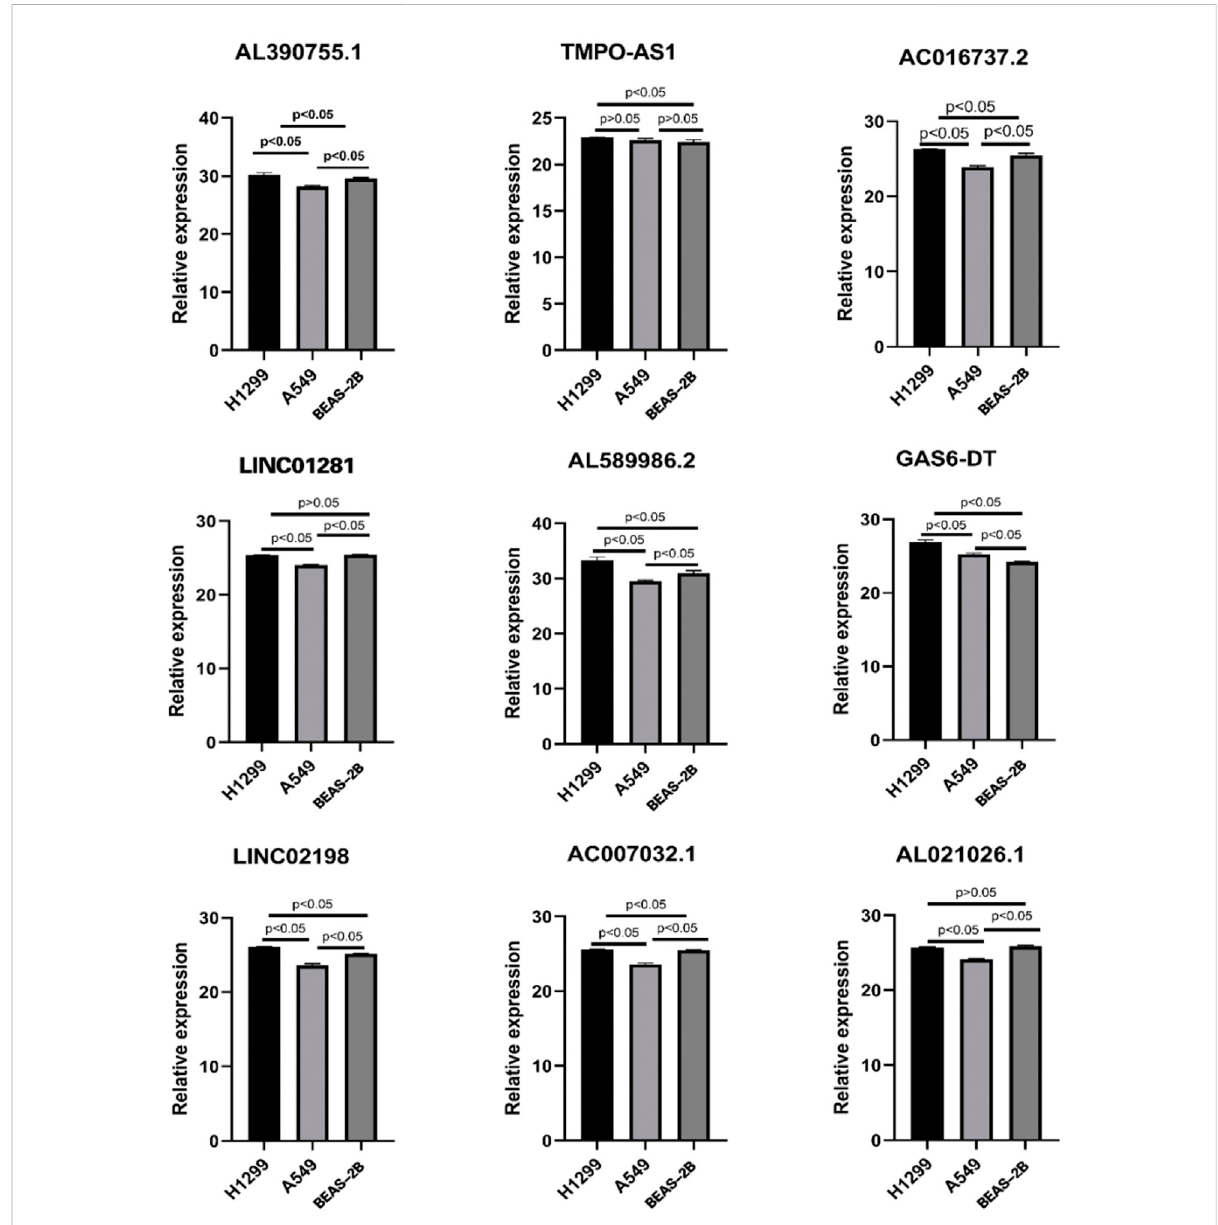
FIGURE 12 Expression of nine lncRNAs from the risk model in LUAD cell lines and bronchial epithelial